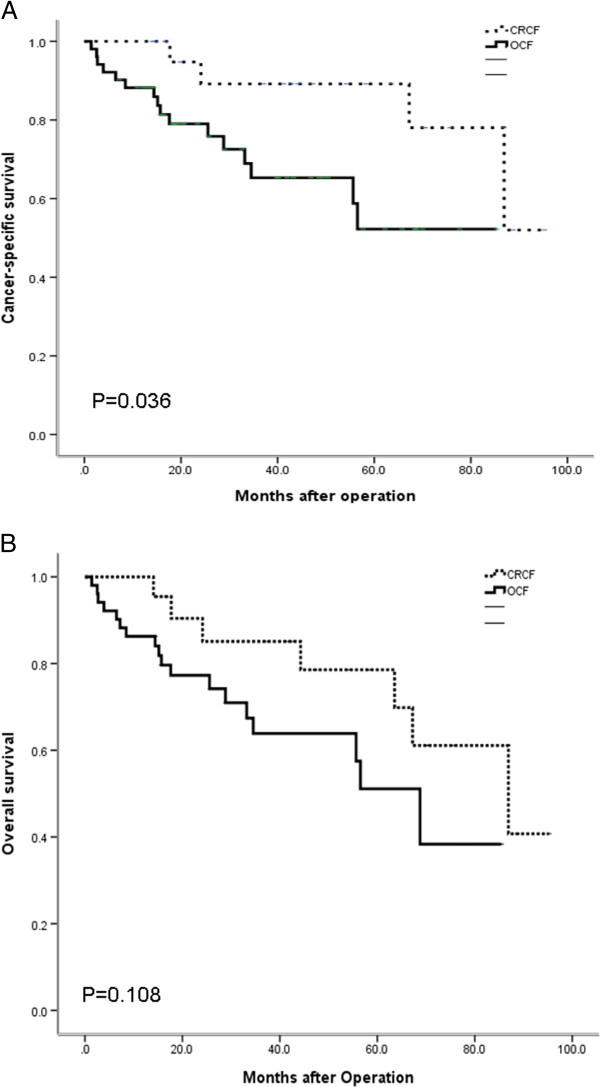
Cumulative survival rates of second primary cancer (SPC) in colorectal cancer (CRC) patients. (A) Cumulative cancer-specific survival rates of SPC in CRC patients. Better survival was observed in the colorectal cancer first (CRCF) group (P = 0.036). (B) Cumulative overall survival rates of SPC in CRC patients. No significant differences were observed between the CRCF and other cancer first (OCF) group (P = 0.108). CRC, colorectal cancer; CRCF, colorectal cancer first; OCF, other cancer first; SPC, second primary cancer.